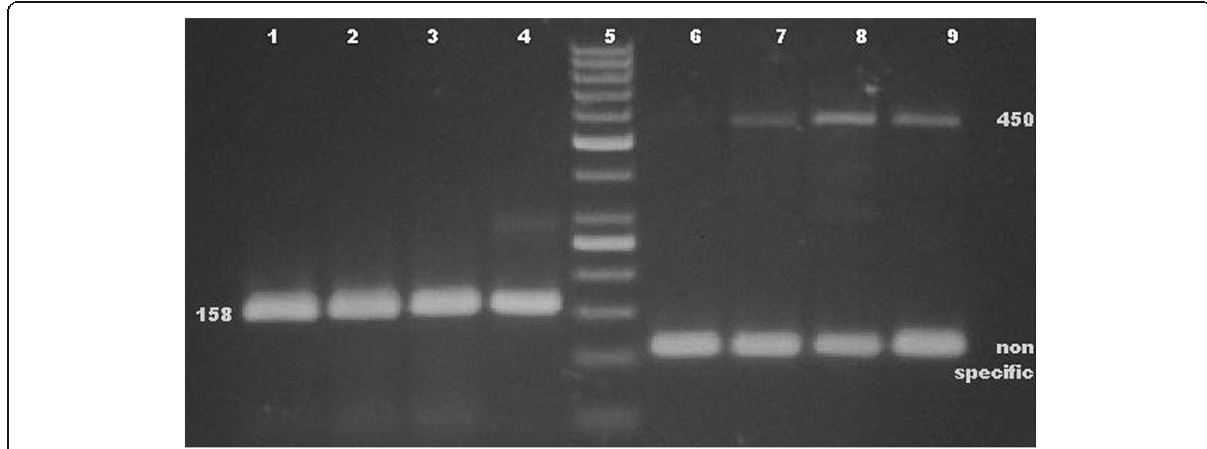
Fig. 1 RT-PCR product of TERRA gene expression and expression of GAPDH (control housekeeping gene). Lanes 1, 2, 3, and 4 represent PCR product of 158 bp for GAPDH; lane 5 represents the 50 bp ladder; lanes 6, 7, 8, and 9 represent PCR product of 450 bp for